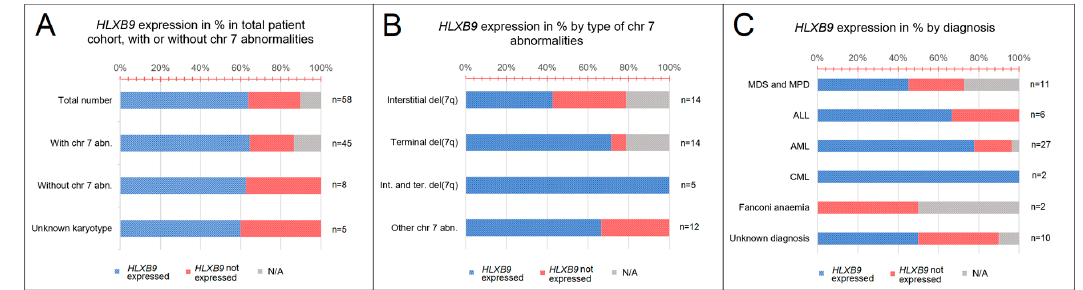
Figure 3. HLXB9 expression patterns in the patients analyzed. ( A ) Graph showing proportion of patients with HLXB9 expression categorised by the type of hematological disorder determined at the time of diagnosis. ( B ) Graph showing HLXB9 expression in the total number of patients considered in this study, categorised into three groups: Patients with or without chromosome 7 abnormalities, and patients with an unknown karyotype. ( C ) HLXB9 expression in patients with chromosome 7q abnormalities by subtype (interstitial, terminal, interstitial and terminal, and other).